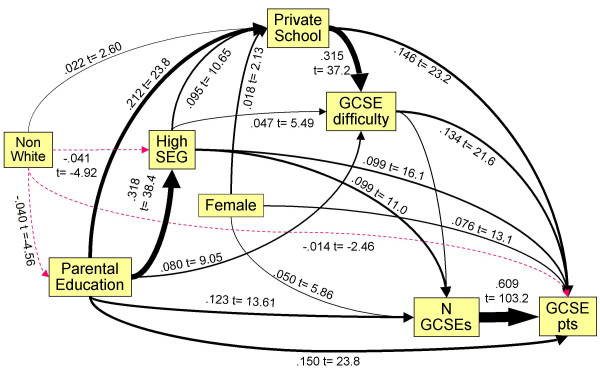
Path model of direct and indirect influences of background factors upon GCSE performance. Path coefficients and t-statistics are shown alongside paths, the thickness of paths is proportional to the path coefficient, and negative paths are shown as red, dashed lines.